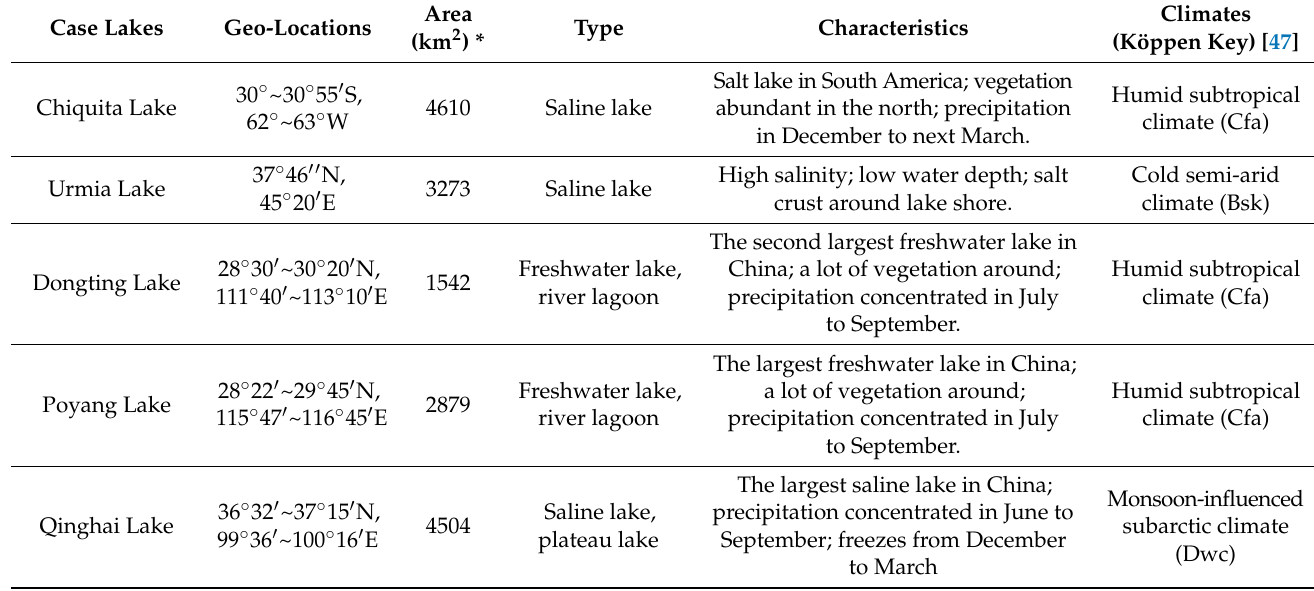
Table 1. Summary of descriptions and characteristics of the case